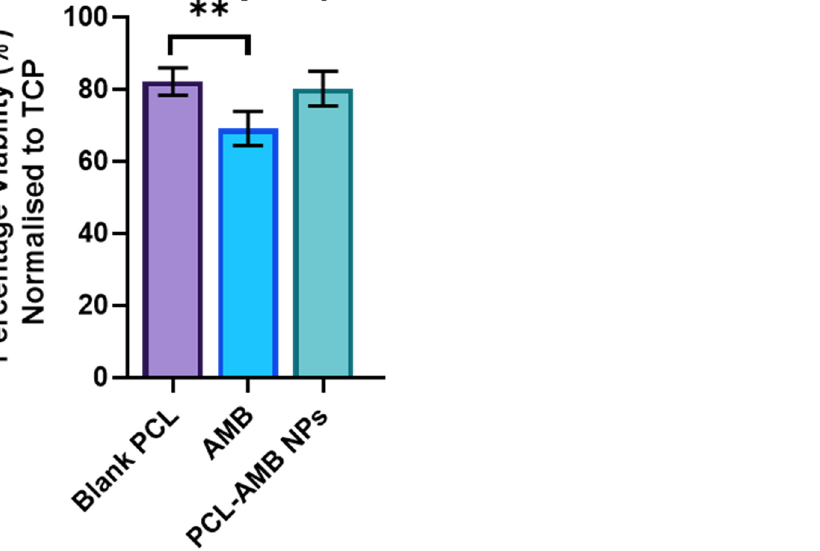
Figure S2: MIC of AMB (A) and PCL-AMB NPs (B); Table S1: Summary of results for the disk diffusion